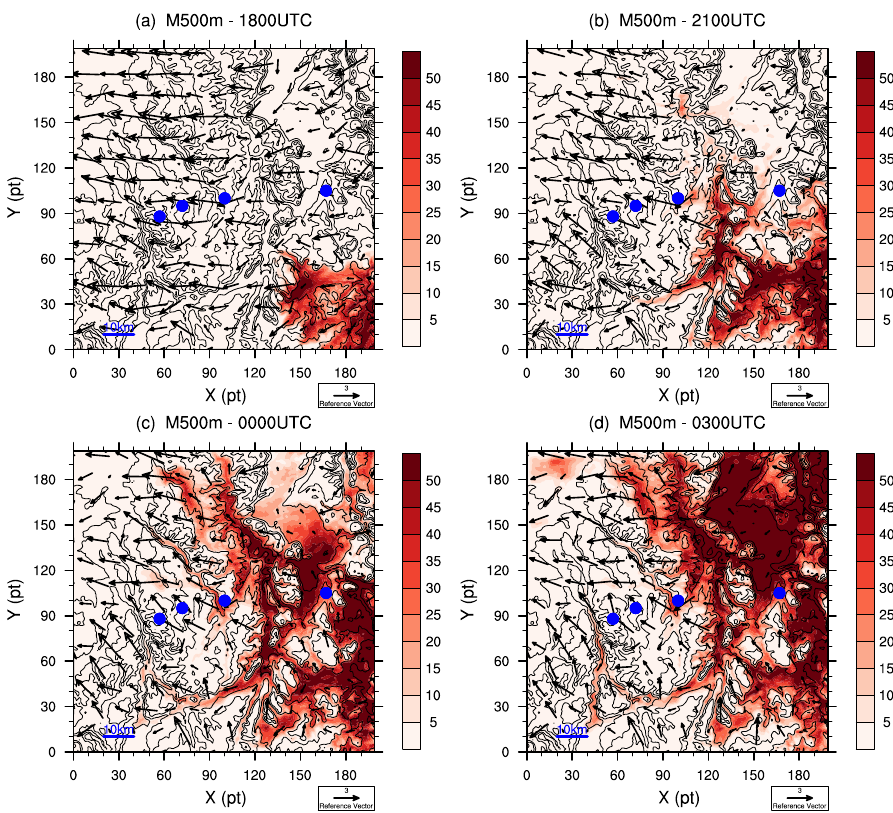
Figure 5. Liquid water path (LWP, gm − 2 ) at 1800 UTC ( a ), 2100 UTC ( b ), 0000 UTC ( c ) and 0300 UTC ( d ) for the M500m model superimposed with orography (thin black lines, contours every 50 m) and wind speed at 10 m (ms − 1 ). The blue dots indicate the locations of the observation sites.